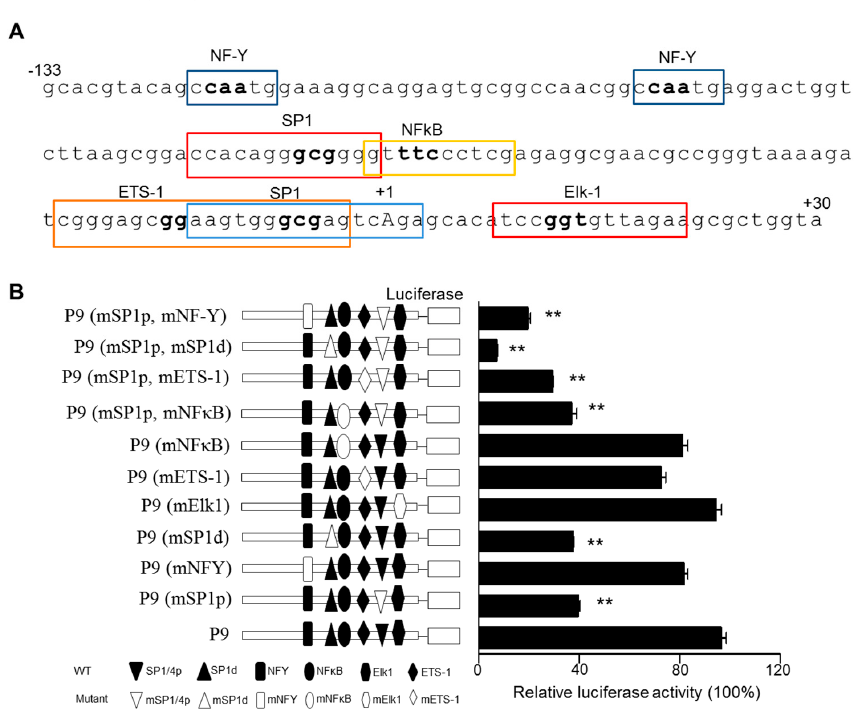
Figure 3. Two putative Sp1 sites are required for the basal promoter activity of human TMBIM6. ( A ) Nucleotide sequence of the core promoter region ( − 133 /+ 30) of TMBIM6, with putative transcription factor binding sites identified in the MatInspector program, have a sequence similarity index > 0.9. Highlighted nucleotides are selected for site-directed mutagenesis. The TSS is designated as + 1. ( B ) Site-directed mutated constructs of identified transcription factor site; each mutation was pictorially represented in comparison to the P9 mother construct. Each mutated construct was transiently transfected into HT1080 cells. After 24 h, luciferase activity was measured. The results are the mean ± SD from n = 3 independent experiments. ‘**’ indicates signi fi cant differences from the P9 at p < 0.01.